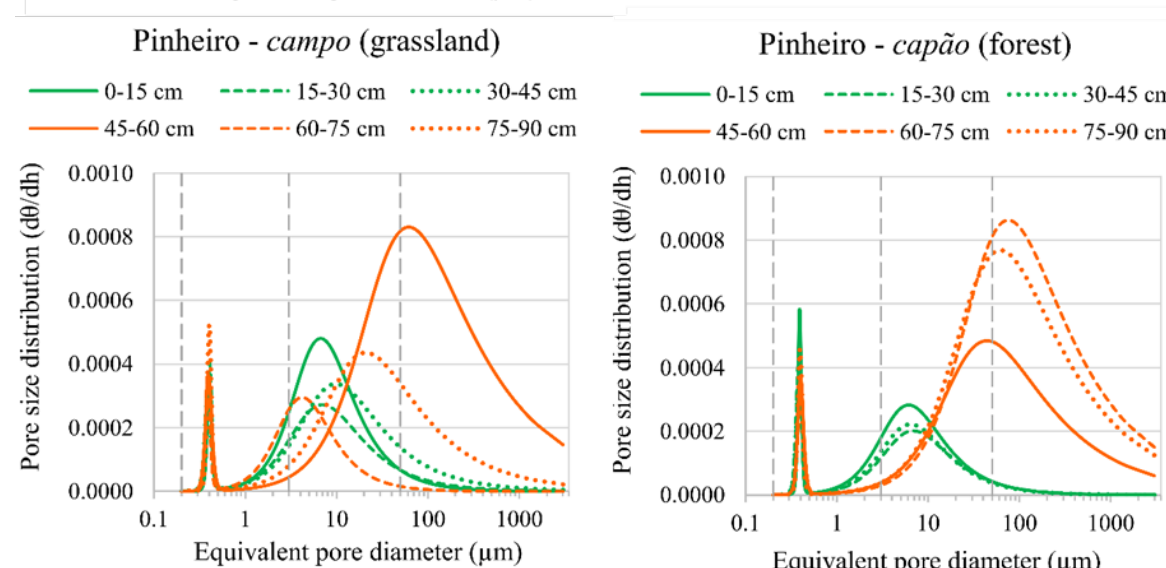
Table 2. The peak relating to the larger pores varied much more broadly, ranging from 4.2 to 229